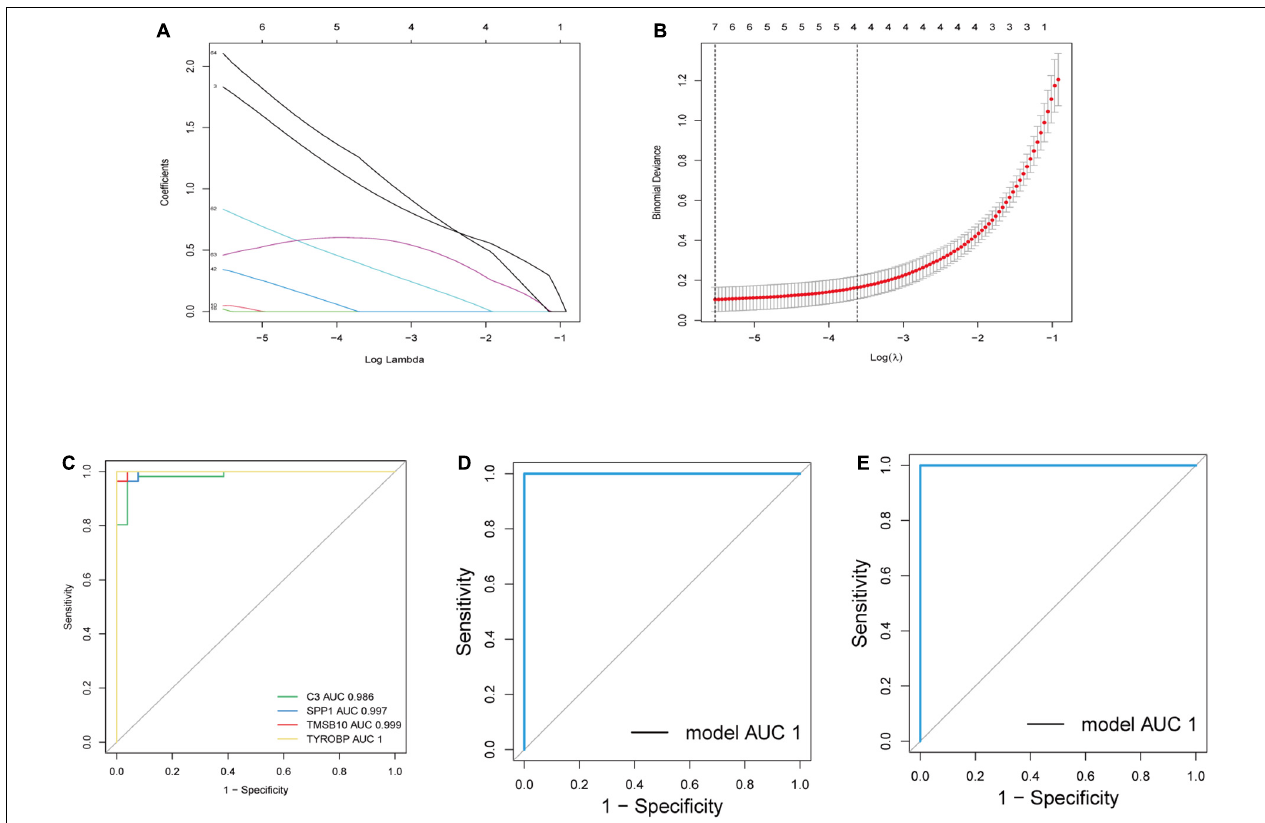
FIGURE 5 | Establishment and verification of a LASSO model. (A) LASSO coefficient profiles of a model featuring the selected four genes. (B) Plots of 10-fold cross-validation error rates. (C) ROC curves for the four candidate genes. (D,E) ROC curves for the four-gene-model in the training dataset and validation dataset. AUC , area under the ROC